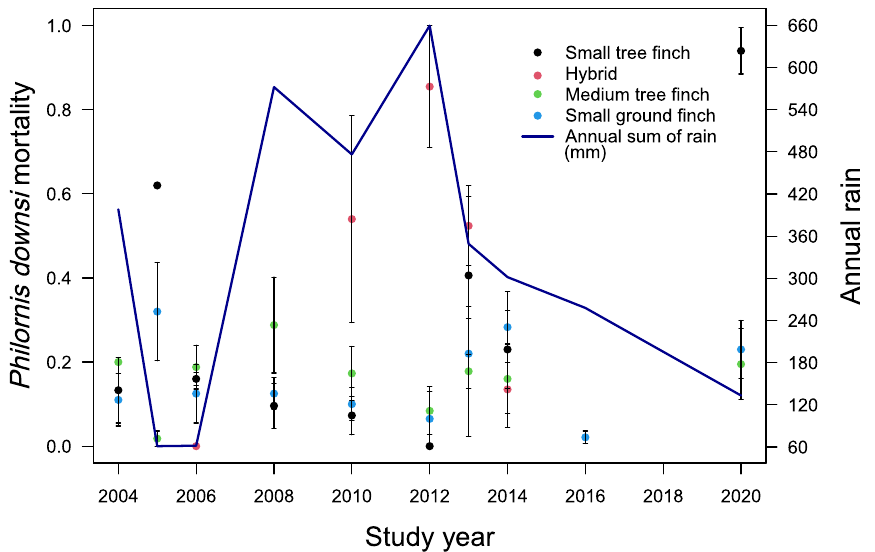
Figure 3. The relationship between avian vampire fly ( Philornis downsi ) in-nest mortality and year across the Darwin’s finch host species, with cumulative annual rainfall on Floreana Island. Dots represent the proportion of vampire fly larvae that died upon termination of the host and are labelled according to the four different Darwin’s finch species.